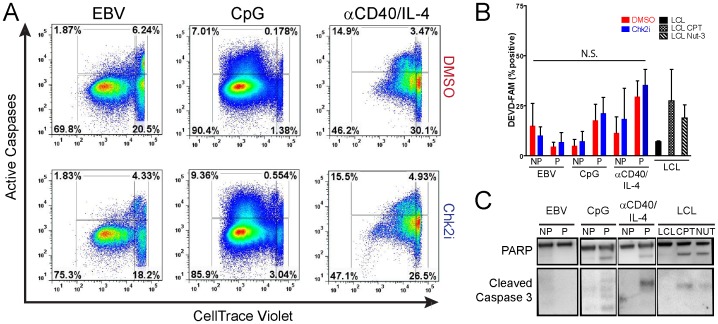
B-cell mitogens, but not EBV, induce caspase 3/7-dependent apoptosis.(A) Activated apoptosis in proliferating B cells treated with DMSO (top panels) or Chk2i (bottom panels) is measured with DEVD-FAM, a fluorescently labeled soluble caspase 3/7 inhibitor. FACS profiles represent CD19+ single cells. (B) Percent of active caspase-positive cells is plotted for non-proliferating (NP) or proliferating (P) EBV-infected, CpG treated, or αCD40/IL-4 treated CD19+ cells in the presence of DMSO (red) or Chk2i (blue). By comparing the Chk2i treated or DMSO treated conditions we found no statistically significant difference in the percentage of active caspase-positive cells by Student’s t test (P-value >0.05; N.S., Not Significant). Activation of caspases was compared to LCLs treated with 15 µM camptothecin (CPT) or 10 µM Nutlin-3 (Nut-3). (C) Cleavage of caspase targets (PARP and self-processing of caspase-3) revealed by western blot analysis of sorted non-proliferating (NP) or proliferating (P) EBV-infected or mitogen-stimulated B cells.